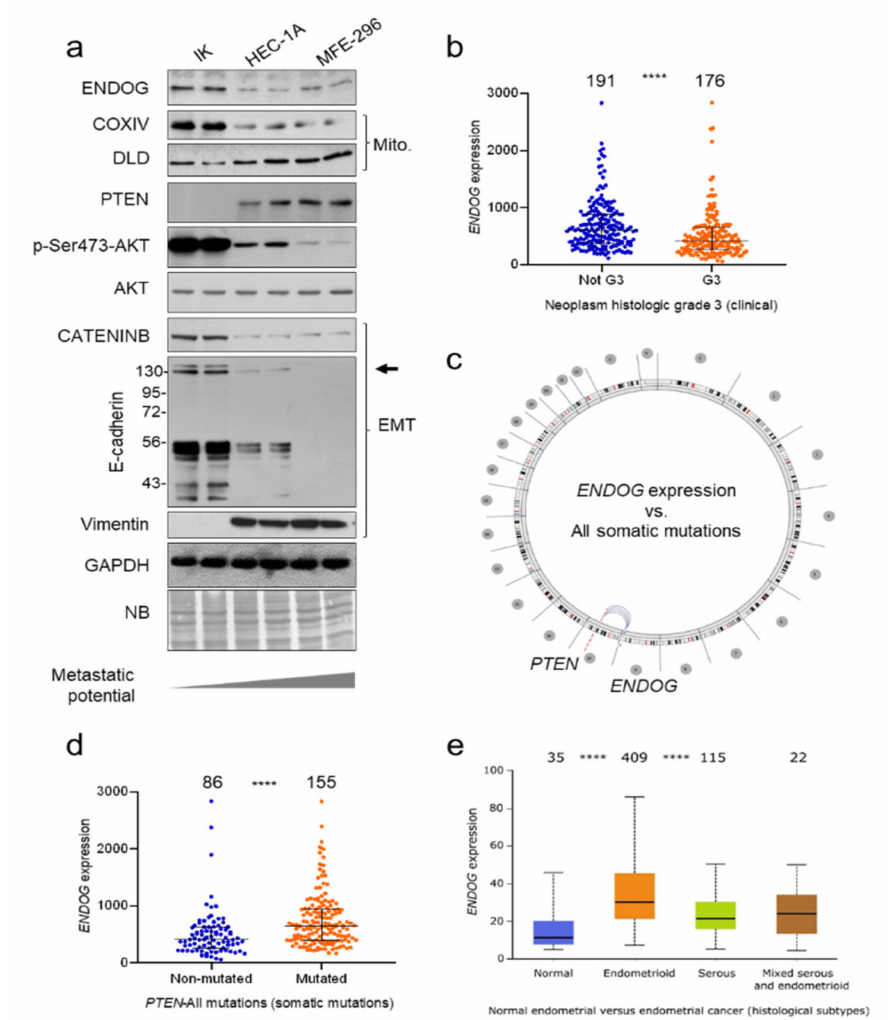
Figure 2. Study of ENDOG expression and its association with PTEN expression and mutations in cell lines and samples of endometrial cancer. ( a ) Expression analysis of relevant genes was performed in total protein extracts of IK, HEC-1A and MFE-296 endometrial adenocarcinoma cell lines. COXIV subunit 4; DLD: Dihydrolipoyl dehydrogenase. For E-cadherin, molecular weight marks are added in kDa, and the arrow on the right indicates the band of full-length protein. ( b ) Correlation of ENDOG expression with the histologic grade of endometrial cancer (carcinoma vs. adenocarcinoma) samples from cBioPortal datasets (https://www.cbioportal.org/). Sample size is indicated on the graph. Individual samples were plotted plus median ± interquartile range. ( c ) Whole genome search for association of ENDOG expression with somatic mutations on the Cancer Regulome Explorer in the UCEC dataset finds only a significant association with PTEN mutations (circular